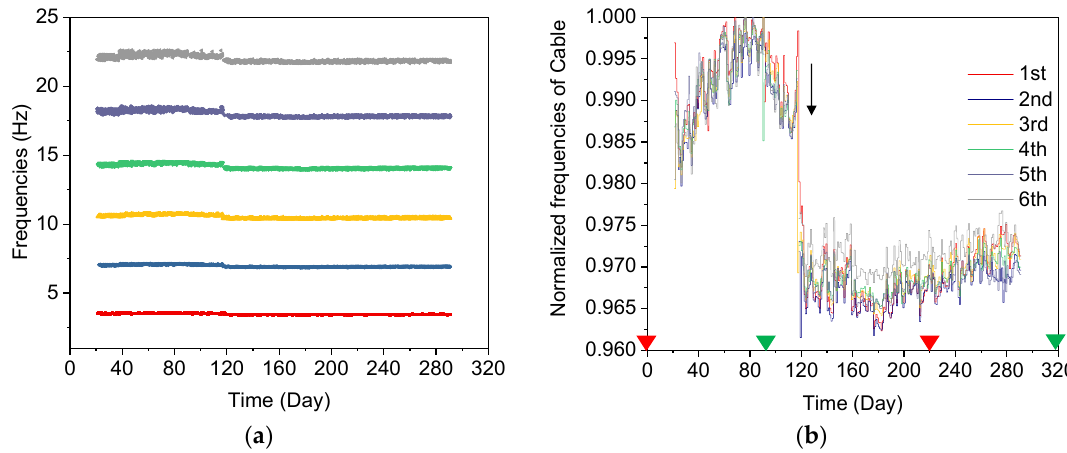
Figure 15. Frequencies of the longest cable (cable 9) from 1 March 2017 to 31 July 2018: ( a ) the long-term frequencies of the cable; ( b ) the average normalized frequencies of the cable.